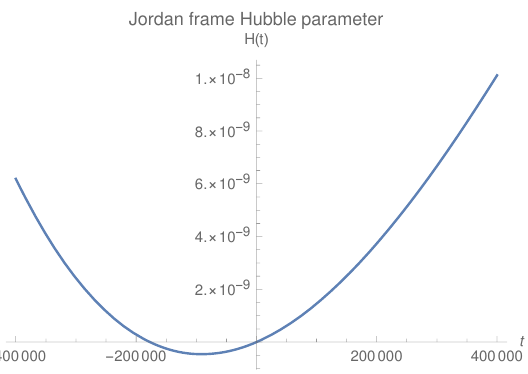
Figure 17. Time evolution of the Hubble parameter in the Jordan frame in radiation background in exponential gravity with the conditions H ( 0 ) = 0, ˙ H ( 0 ) = 10 − 14 , ¨ H ( 0 ) = 10 − 19 .